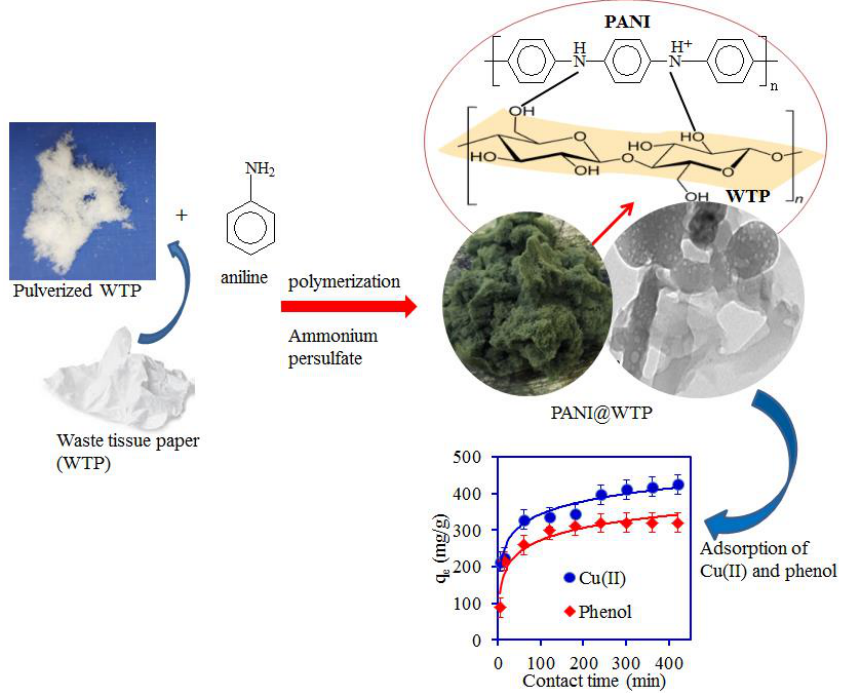
Figure 1. A proposed scheme for the PANI@WTP nanocomposite synthesis and application.